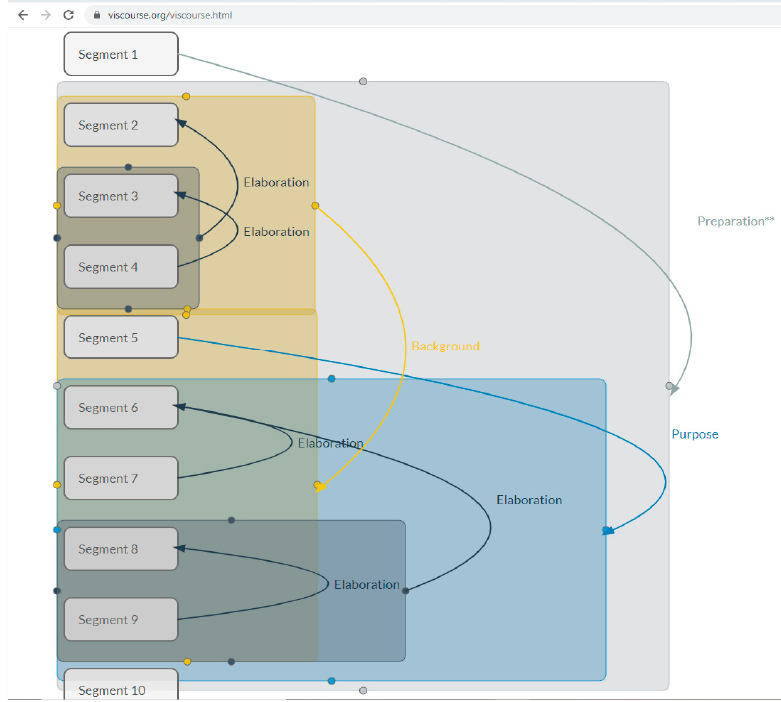
Figure 3. Viscourse textual analysis for the bouquets in the basket RST corpus text. Simplified mode.